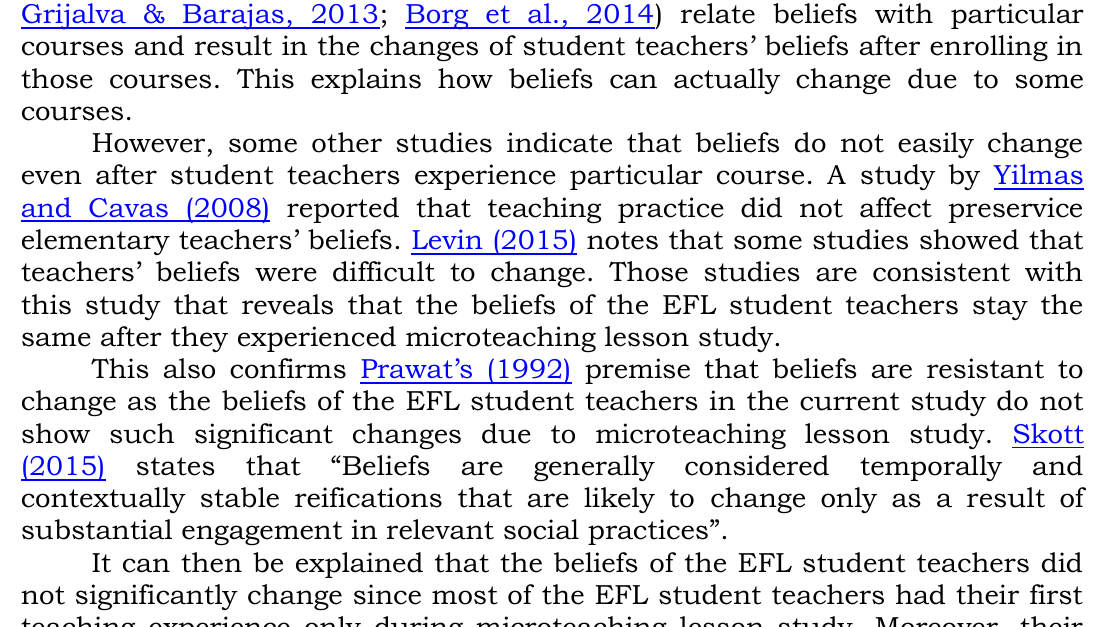
Sig. (2- t df tailed) Mean